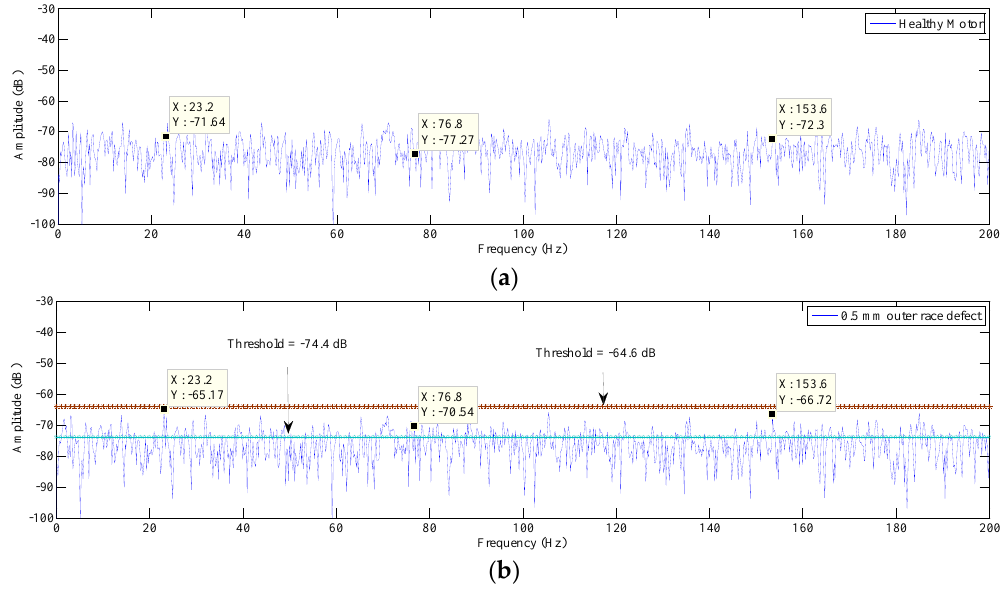
Figure 7. The PV modulus spectrum of the motor under medium-load condition at bearing fault frequencies of 23.2 Hz, 76.8 Hz and 153.6 Hz ( a ) Healthy bearing ( b ) Defected bearing.